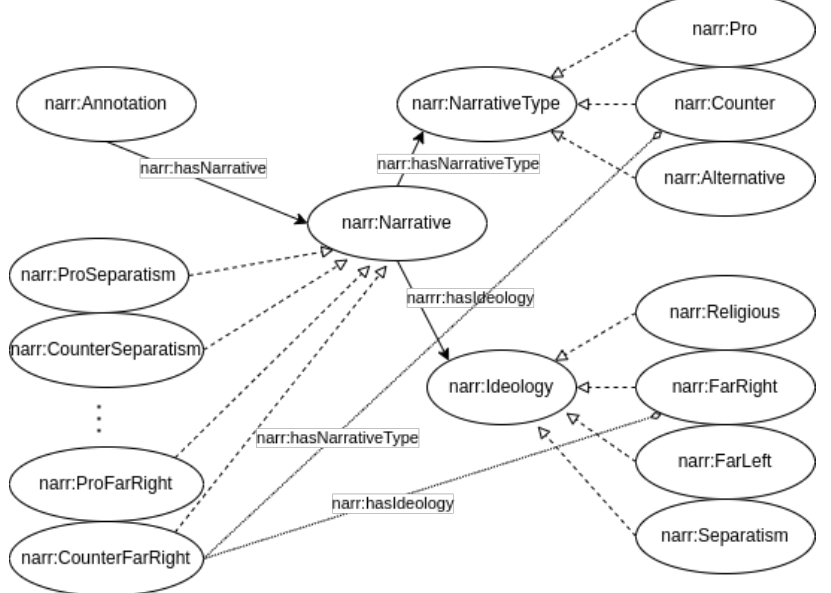
Figure 5. The narrative ontology. For clarity, only the relationships of one narr:Narrative (narr:CounterFarRight) with narr:NarrativeType and narr:Ideology are shown.